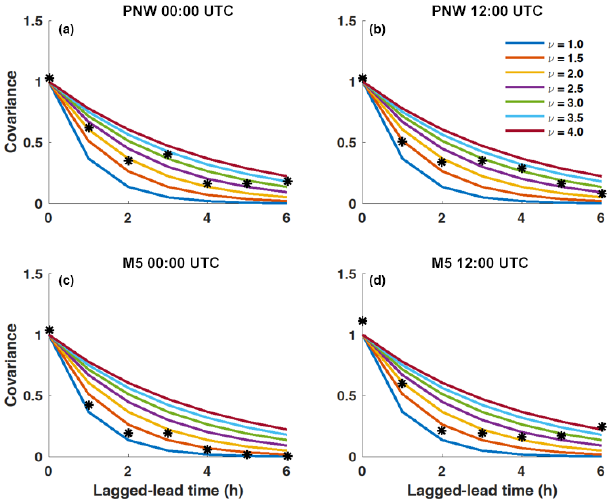
Figure A1. Exponential correlation models (solid lines) given dif- ferent values of the range parameter ν ranging from 1 to 4 in in- crements of 0.5 as a function of lagged–lead time. Overlaid are the observed covariance values (black asterisk) of the Gaussian wind speed values. Empirical covariances and the fitted exponential cor- relation models are shown for the PNW (a, b) and M5 (c, d) tower locations for 00:00UTC (a, c) and 12:00UTC (b, d) forecast ini- tialization